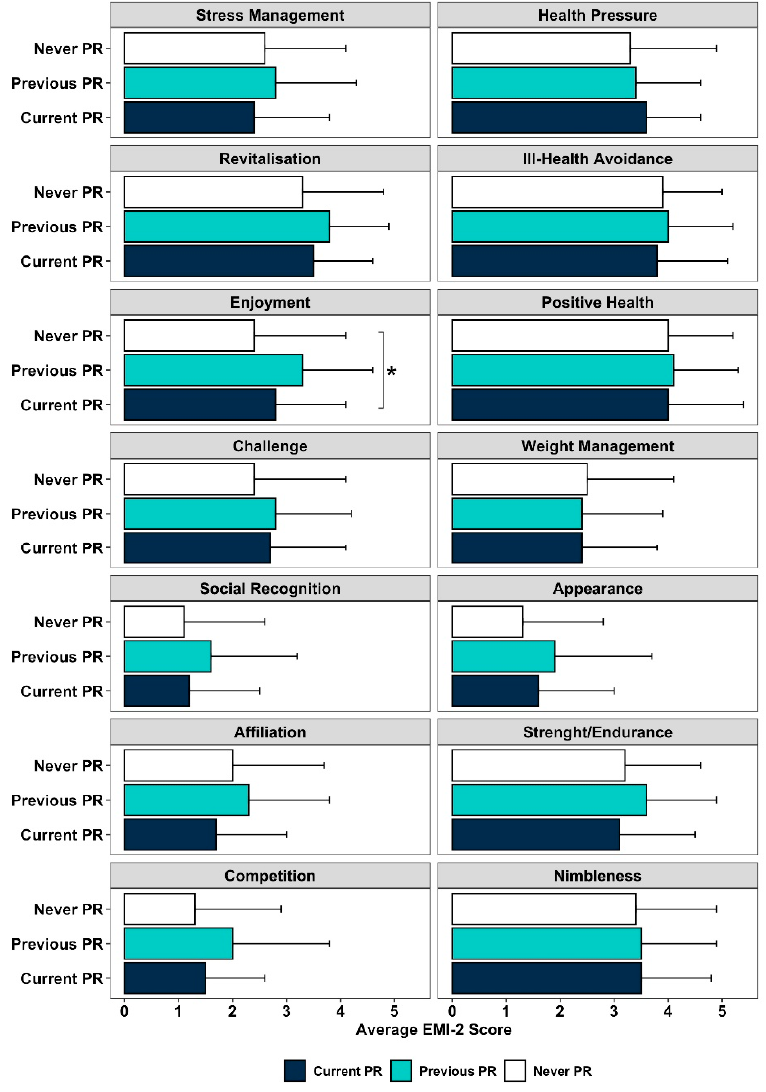
Figure 1. Motivational factors of the Exercise Motivation Inventory-2 (EMI-2) among the PR participation groups ( n = 92; * p < 0.05).